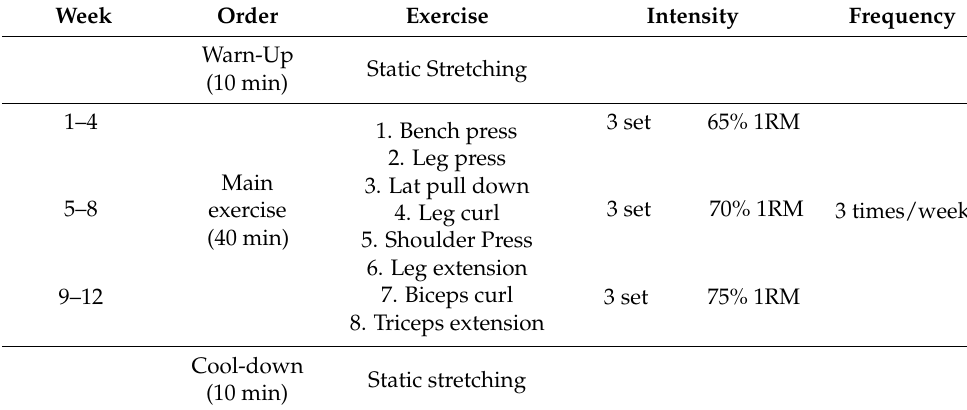
Table 2. Resistance training